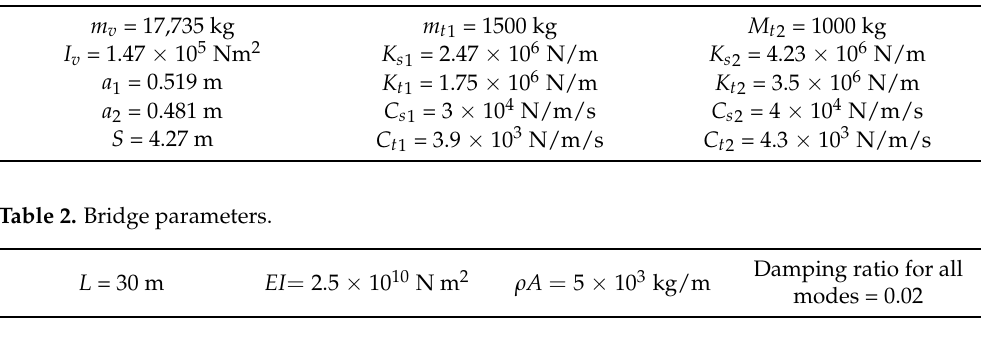
Table 1. Vehicle parameters.